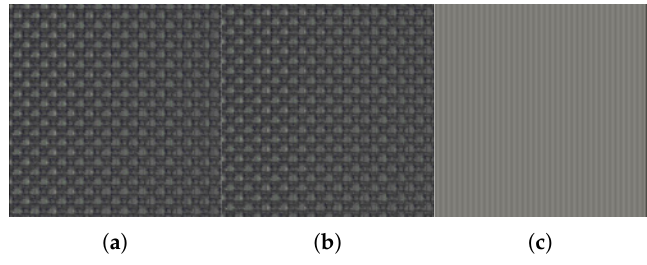
Figure 8. Small, periodic and regular (SPR) pattern images (256 × 256) of an AMOLED panel ( a ) by SSM with Tenenbaum ( b ) by equal search with Tenenbaum and ( c ) equal search with